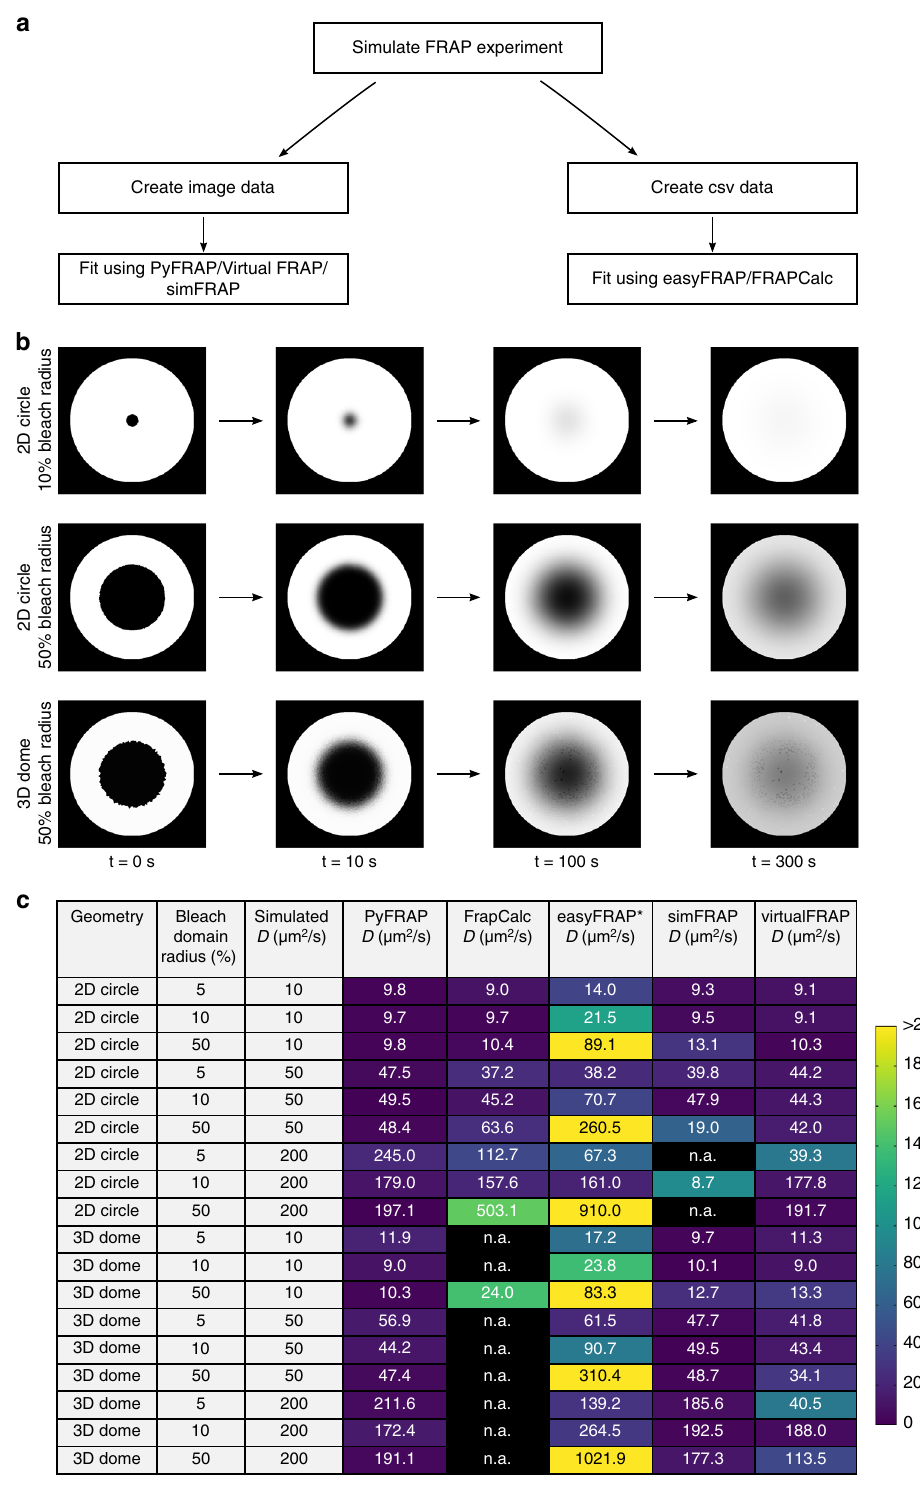
Fig. 3 PyFRAP benchmarking simulation experiment. a Work fl ow of PyFRAP benchmarking. b Examples of simulated data sets for different bleach spot sizes and geometries. c Benchmarking results of PyFRAP against currently available software packages using simulated FRAP experiments. Simulation experiments varied in bleached region size, diffusion coef fi cient and experiment geometry. All diffusion coef fi cients and estimates are given in units of μ m 2 /s. n.a. indicates that the software was not able to fi t the simulated data. Colours indicate relative estimation error in %. Diffusion coef fi cients determined by easyFRAP (asterisk) were computed in combination with an equation providing a relationship between recovery rate, bleached domain size and diffusivity